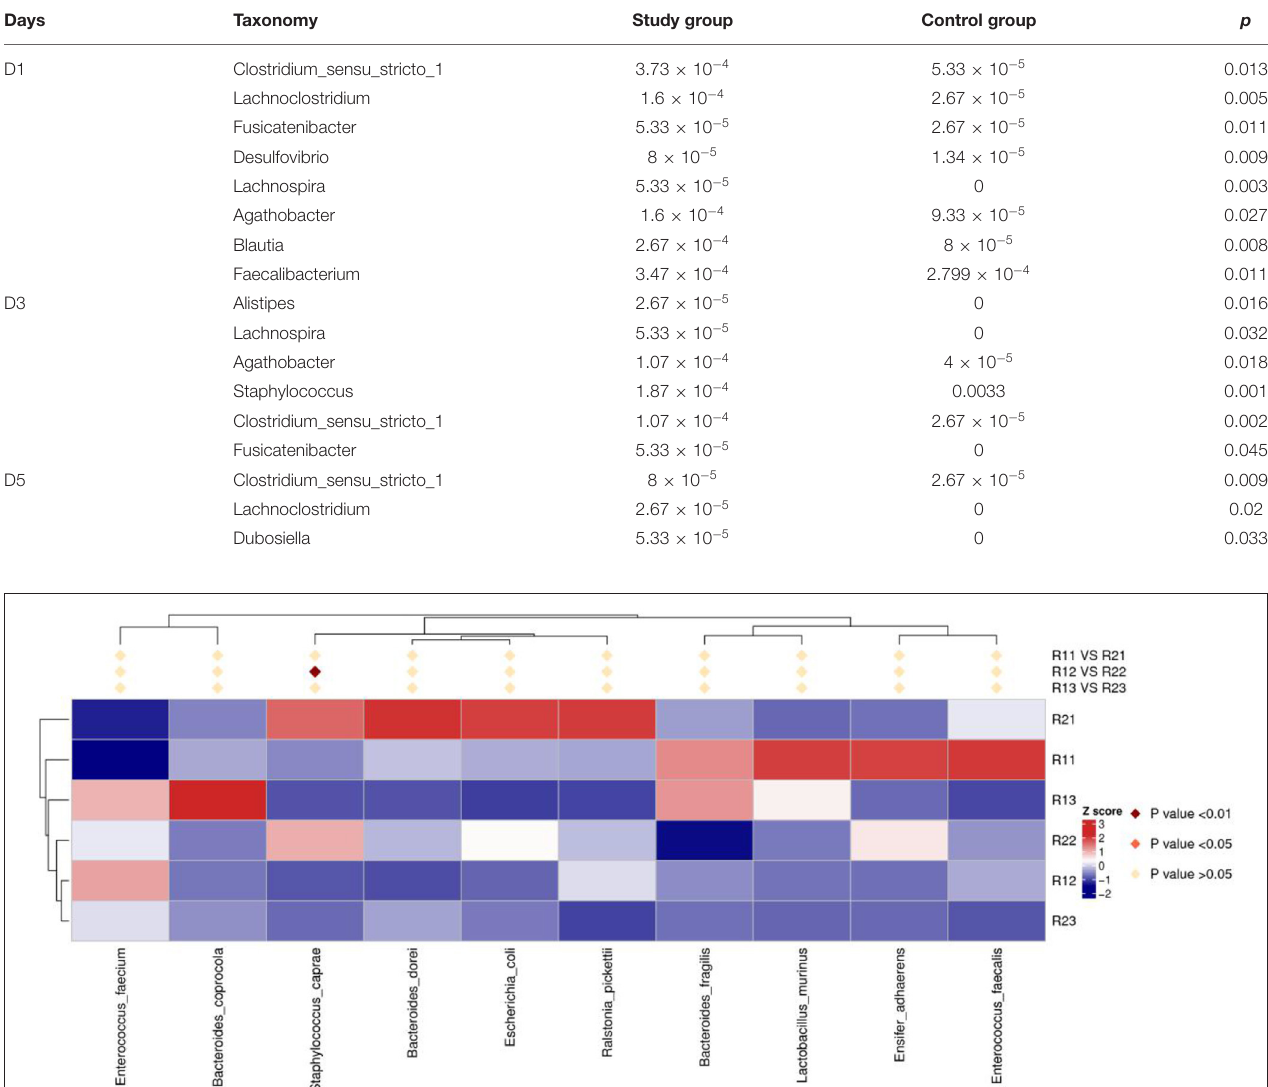
TABLE 2 | Comparison of the relative abundance of microbiota of the study group and control group at the genus level on days 1, 3, and 5.